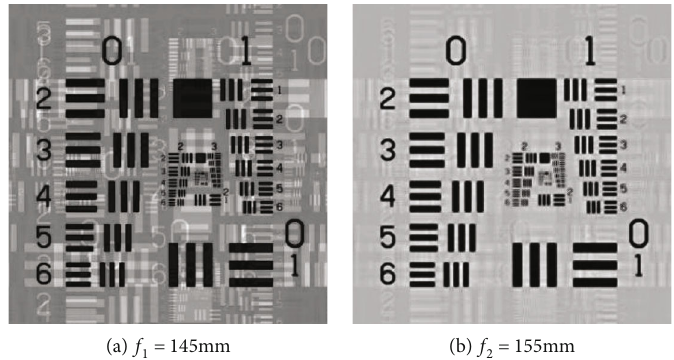
Figure 4: Comparison of the resolution of the two di ff raction modes.